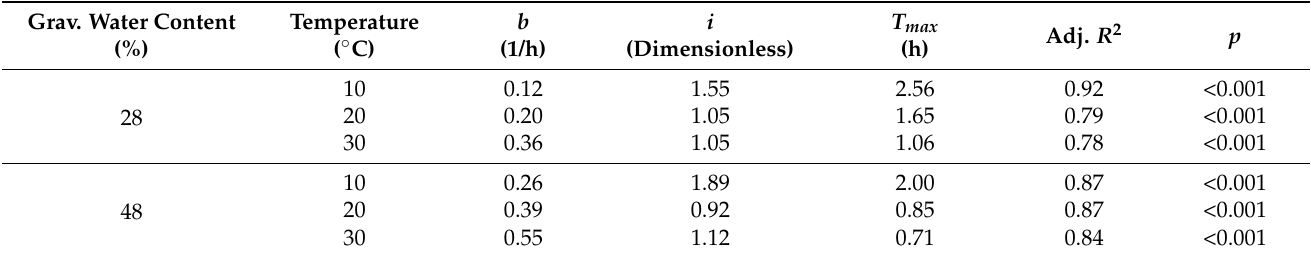
Table 1. Effect of temperature on urea granule dissolution by nonlinear regression (Equation (2)) on simplified sigmoidal function ( T max = ln( b / i )).